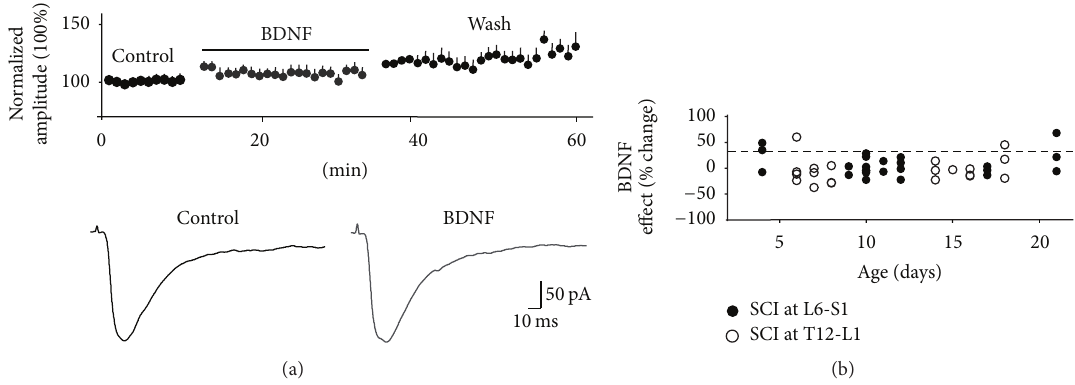
Figure5:BDNFfailstoinducesynapticfacilitationafterSCI.(a)Normalizeddata(mean ± SEM)averagedoverallneuronsshowthatsynaptic facilitation was abolished after transection (at L6-S1 or T12-L1) or contusion (at T12-T13) SCI. (Some data points have smaller error bars than the points used to define the data.) Bottom: the average synaptic traces are shown for synaptic recordings obtained from a neonatal rat with contusion SCI before and during BDNF. (b) Mean percent change in synaptic amplitude in the presence of BDNF versus age is shown for each animal that received a transection injury. Although the effect of BDNF is somewhat variable, overall the effect is much reduced compared to the average facilitation of ∼ 30% (represented by the horizontal dotted line) which was seen in uninjured animals of similar age. Also, BDNF’s effects are not dependent on the location of injury. Recordings were done in L2–L5 lamina II neurons. From data previously reported in Garraway et al. [90,